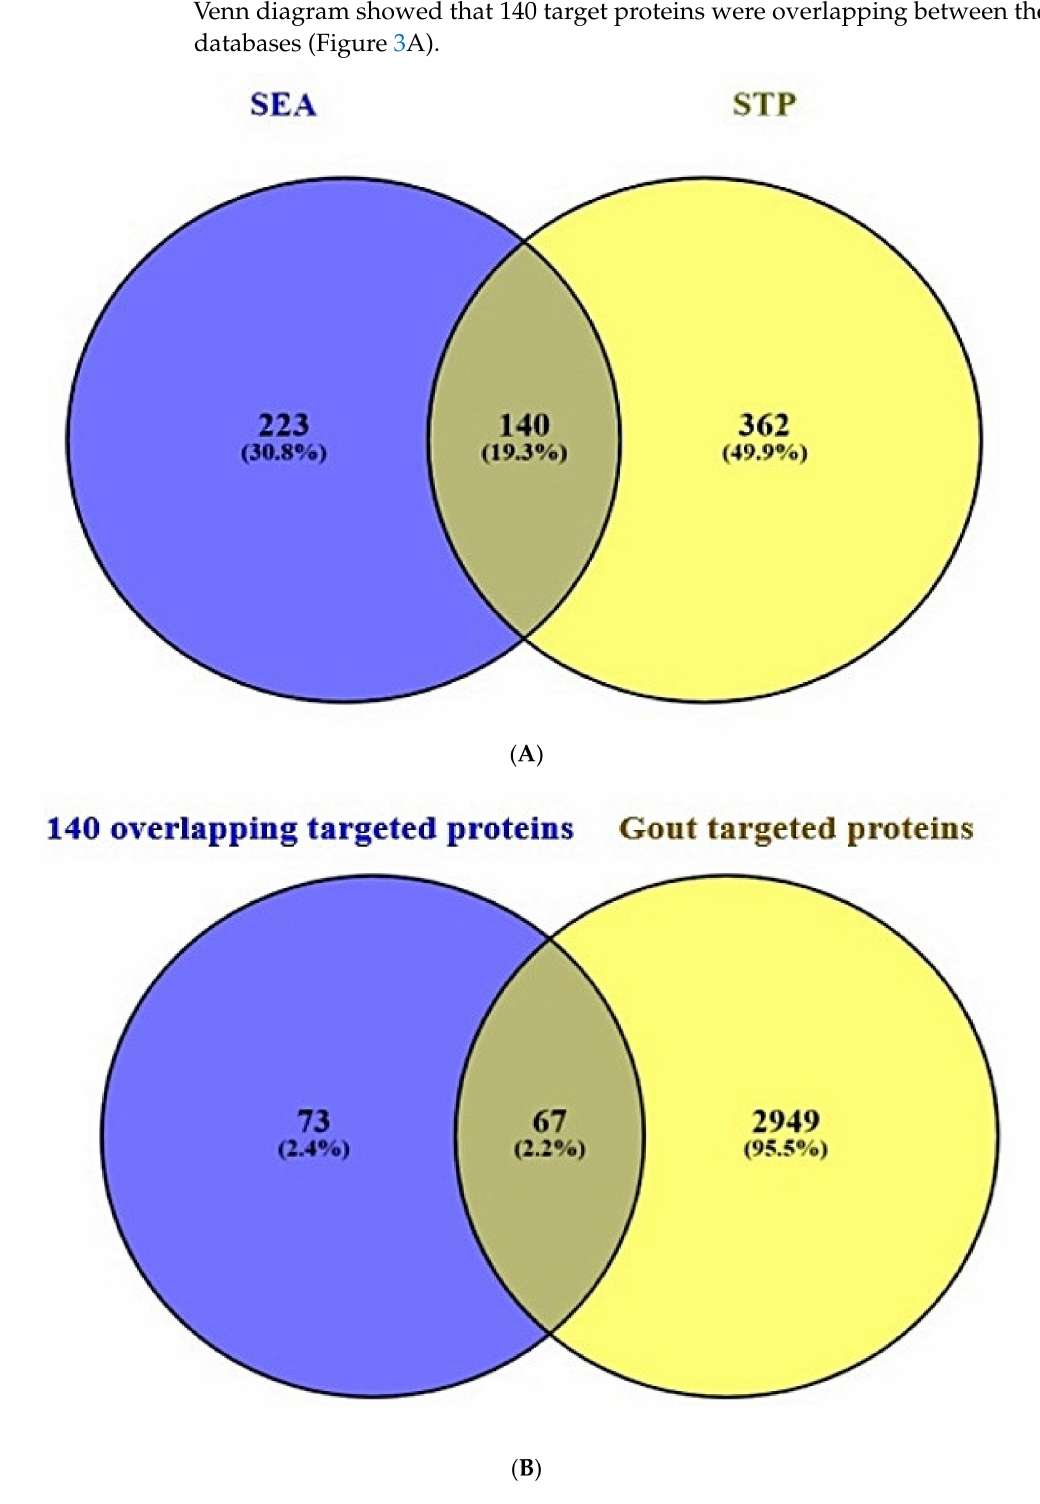
Figure 3. ( A ) Overlapping target proteins (140 target proteins) between SEA (223 target proteins) and STP (362 target proteins) ( B ) Overlapping target proteins between 140 overlapping target proteins from two databases (SEA and STP) and gout associated with target proteins (3016 target